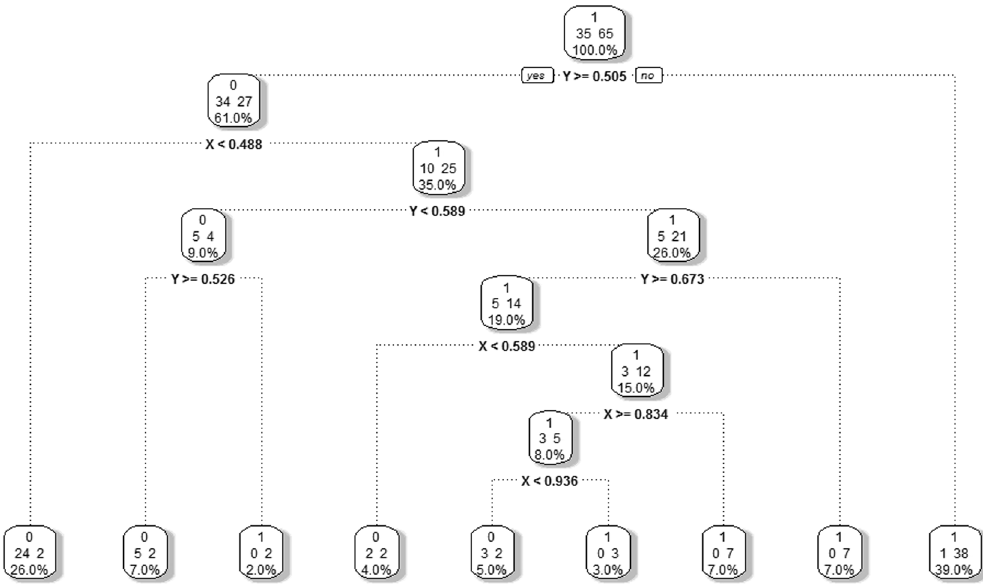
Figure 4. Unpruned full recursive partitioning tree fit to the simulated data in Fig. 2.